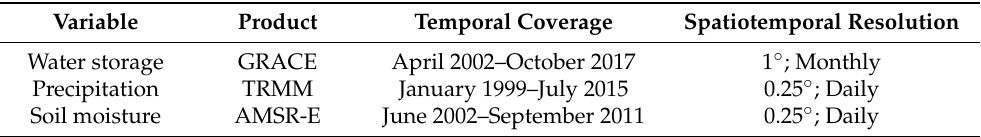
Table 1. Temporal coverages and resolutions of the Gravity Recovery and Climate Experiment (GRACE), Tropical Rainfall Measuring Mission (TRMM), and Advanced Microwave Scanning Ra- diometer for Earth Observing System (AMSR-E)